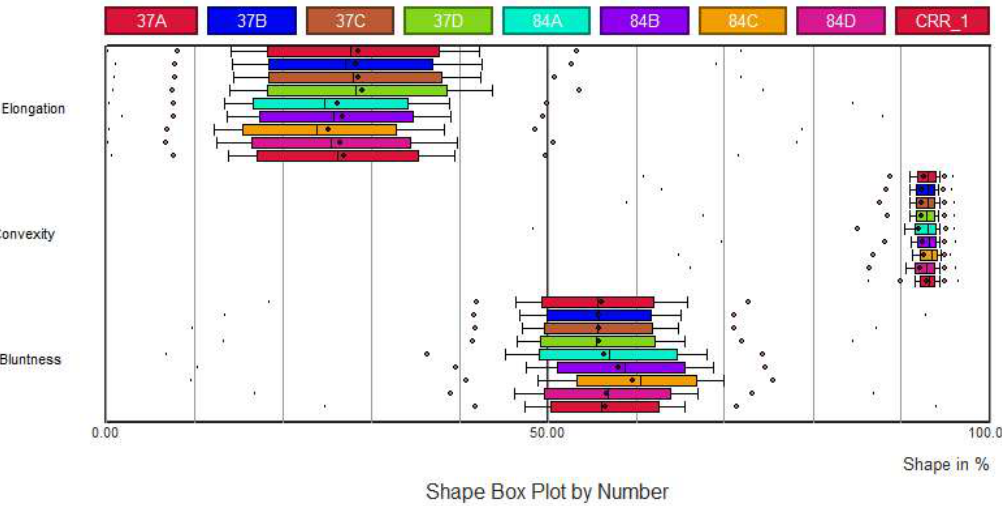
Figure A3. Shape analysis of particles (1–2 mm).